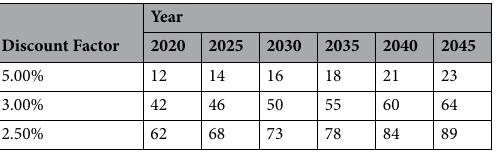
Table 5. SCC in US$/ton of carbon emission at different discount